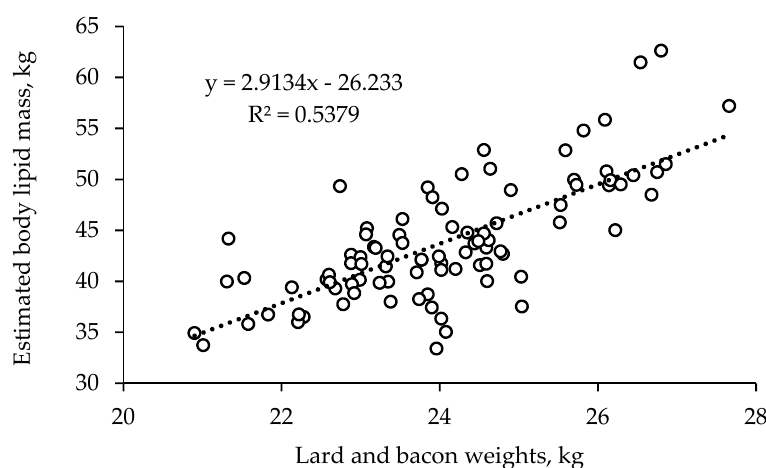
Figure 1. Correspondence between weights of the lard and bacon and body lipid mass estimated from in vivo measurement of body weight and backfat depth.